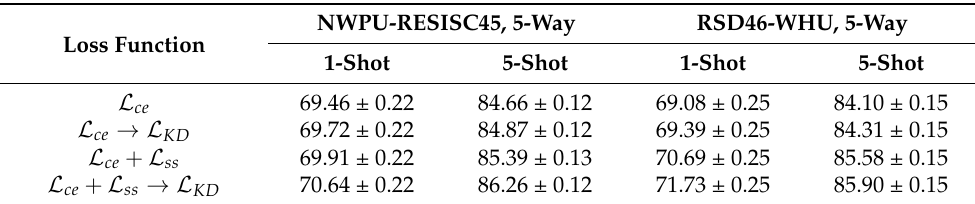
Table 4. Few-shot classification results on NWPU-RESISC45 and RSD46-WHU, with different auxil- iary loss functions.